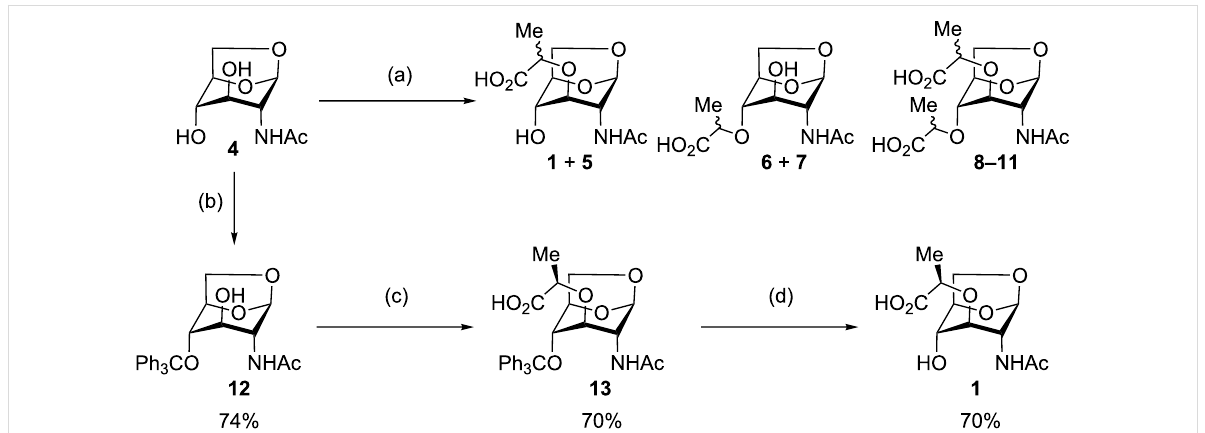
Scheme 2: Synthesis of AnhydroMurNAc. Conditions: (a) (±)-2-chloropropionic acid, NaH, dioxane, 45 °C to 90 °C, 2 h; (b) TrOTf, collidine, CH 2 Cl 2 , rt, 2 h; (c) ( S )-2-chloropropionic acid, NaH, dioxane, 45 °C to 90 °C, 30 min; (d) trifluoroacetic acid, CHCl 3 , 0 °C to rt, 3